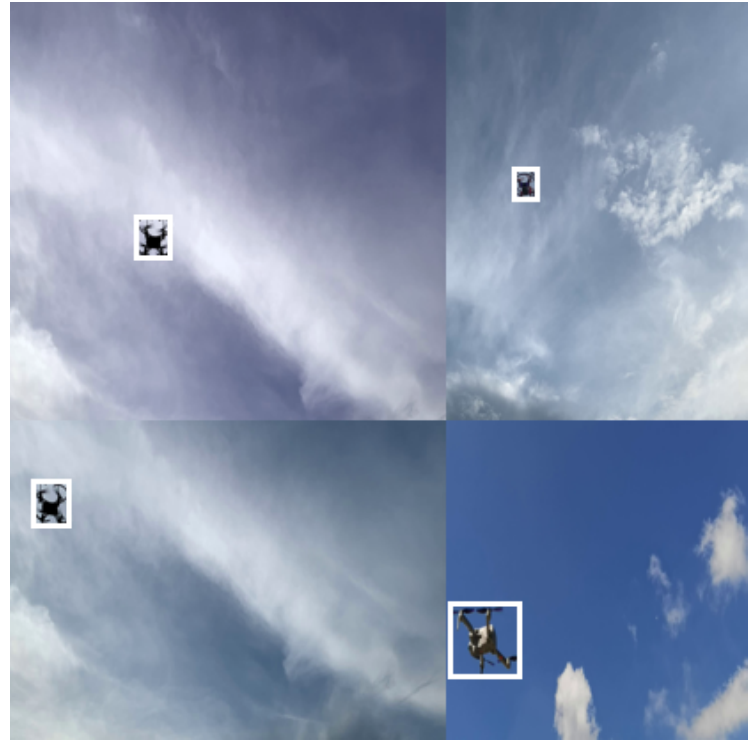
Figure 10. The result of merging images and combining